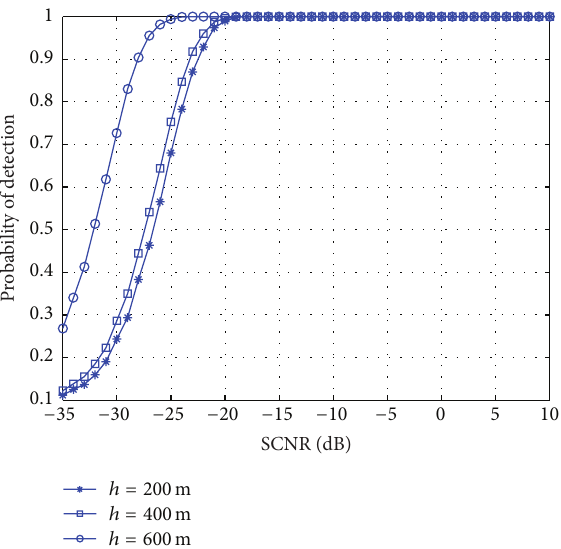
Figure 6: Detection performance of GLRT-LQ detector with differ- ent numbers.